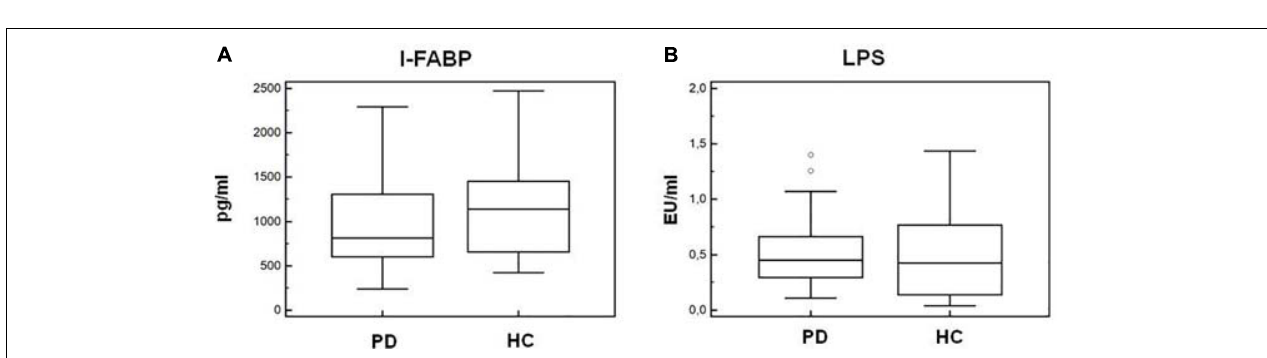
FIGURE 8 | IL-10 anti-inflammatory cytokine production by monomeric or aggregated α -synuclein–stimulated cells of PD and HC subjects. IL-10 production was analyzed in supernatants from PBMCs cultures of Parkinson disease (PD, n = 15) and healthy controls (HC, n = 15). PBMCs were unstimulated, LPS-stimulated, monomeric α -synuclein–stimulated, aggregated α -synuclein–stimulated, LPS-primed and monomeric α -synuclein–stimulated, or LPS-primed and aggregated α -synuclein–stimulated. Summary results are shown in the bar graphs. The boxes stretch from the 25th to the 75th percentile; the line across the boxes indicates the median values; the lines stretching from the boxes indicate extreme values.